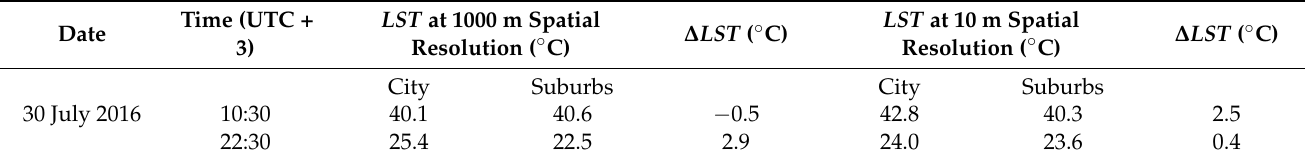
Table 9. The LST values for both city and suburbs at 1000 m and 30 m spatial